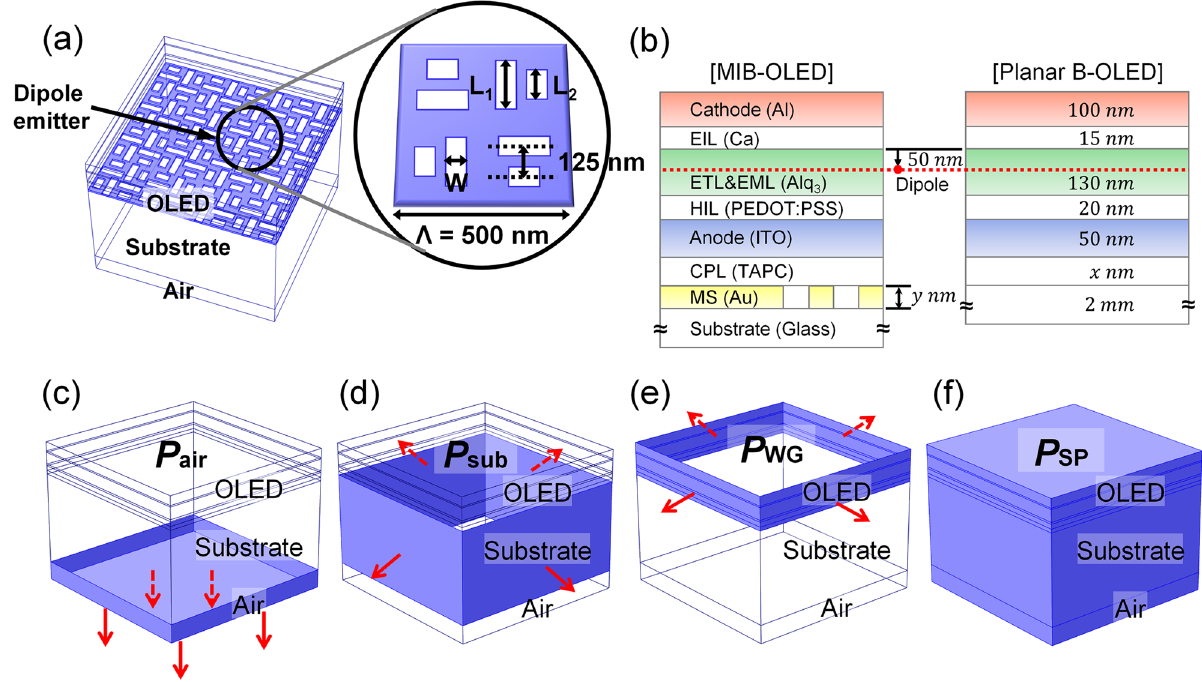
Figure 1. ( a ) 3D schematic illustration of the calculation model with MS integrated B-OLED (MIB-OLED, MS layer in blue). A dipole emitter is located at the center of the device. Emitted light from the dipole emitter is directed to the bottom through glass substrate to air ambience. One of the unit cells of the MIB-OLED is shown enlarged in the inset. Lengths and widths of the eight cut-out slots are indicated to L 1 , L 2 , and W ( Λ = 500 nm). ( b ) 2D layer cross-section of the MIB-OLED vs. conventional planar B-OLED with materials and thicknesses of the model. The vertical location of the dipole emitter is 50 nm apart from EIL for constructive two-beam interference of micro-cavity effects. ( c – f ) Schematic illustration of the surface and the domain used to calculate the coupling mode power of the B-OLED. The amplitude of Poynting vectors through blue-colored surfaces of ( c ) air, ( d ) substrate, and ( e ) OLED device represents the power coupled to the air, substrate, and WG modes. The red arrows represent the direction of Poynting vector in each mode. ( f ) Plasmon loss is calculated by the integration of power dissipation in the whole volume of the OLED